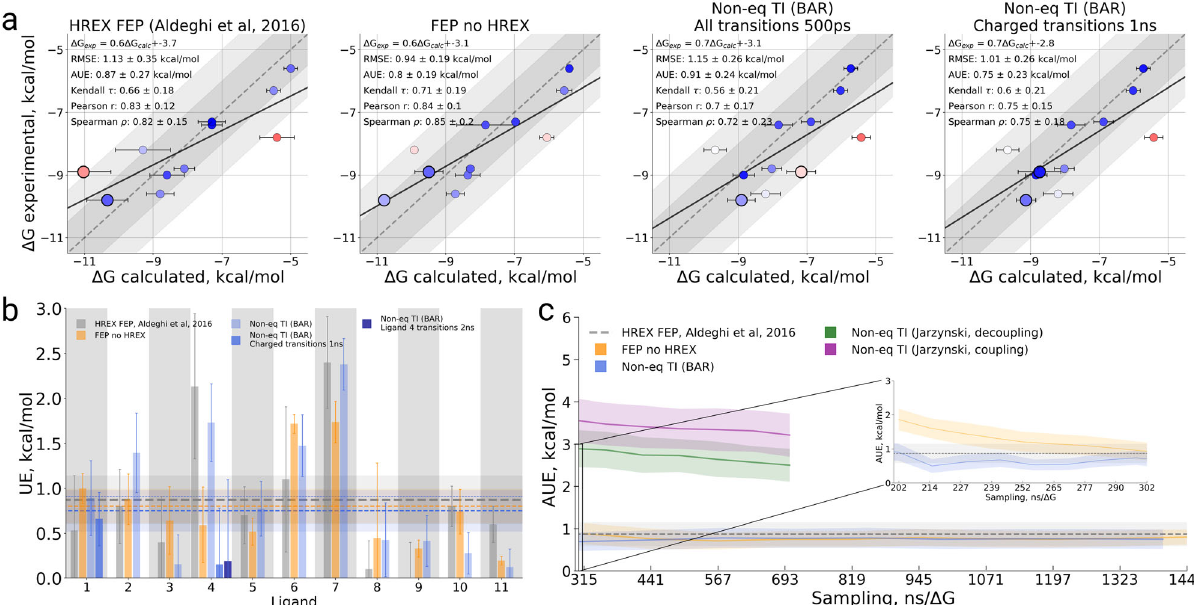
Fig. 3 Binding free energy calculation summary for the BRD4(1) speci fi city study. a Calculated vs experimental Δ G values for the HREX FEP 7 , FEP without sampling enhancement, and non-equilibrium TI approaches. Two versions of the latter method are depicted: all transitions of 500 ps and extended 1 ns transitions for the charged ligands (Ligand 1 and Ligand 4). The larger circles in every panel denote Ligand 1 and Ligand 4. In the panels we also provide a linear regression fi t as well as RMSE, AUE, Kendall, Pearson, and Spearman correlations. b Unsigned error (UE) by ligand for each of the considered protocols. c Average unsigned error (AUE) with respect to experimental measurement for varying sampling time invested in each of the approaches studied. The time re fl ects only the sampling invested in the protein – ligand coupling part of the calculation. The dashed line for HREX FEP 7 marks the accuracy of the estimate using the whole available sampling, i.e., it does not depict dependence on the sampling time. The inset shows the behavior of AUE for FEP and bi-directional non-equilibrium TI when less than 10% of the sampling production time is considered for the Δ G estimation. The uncertainties denote standard errors obtained by